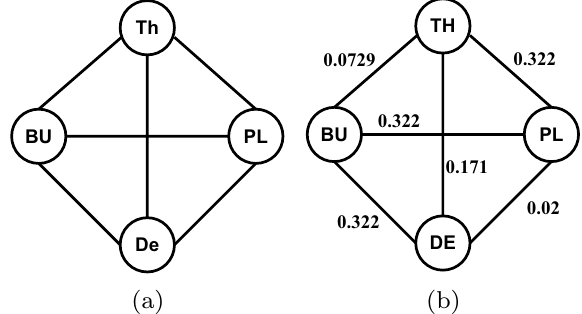
Fig. 4 Bayesian network Structure Learning (a) Initial Complete Graph for input data shown in Eq. (1) (b) Mutual information of each possible